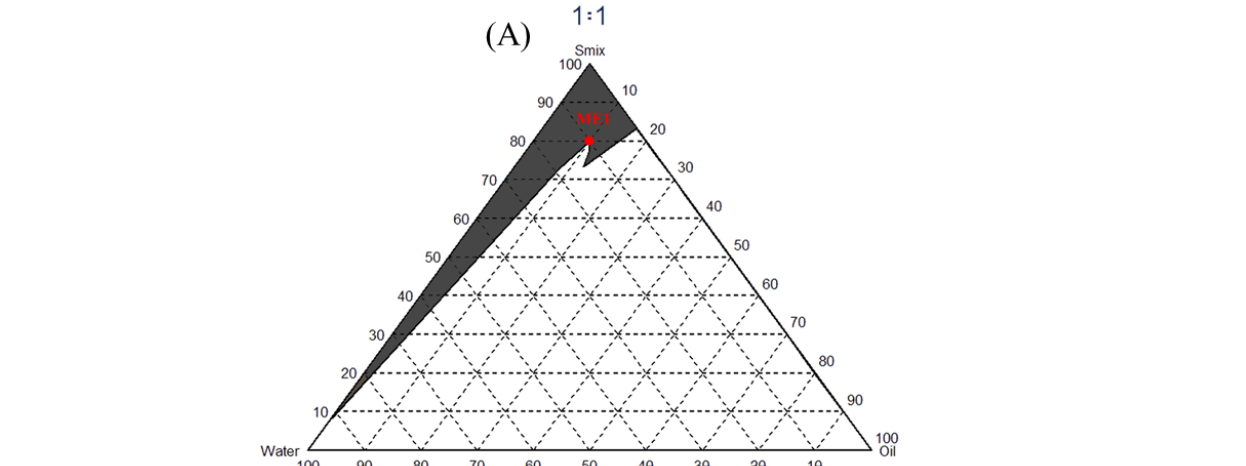
Figure 2. The pseudoternary phase diagram of the microemulsion formation with different tween 80 and ethanol ratios. The black area indicates the microemulsion formation. Red dots indicate the selected formula, which produces the microemulsion with less surfactant. ( A ) A 1:1 ratio of tween 80: ethanol, ( B ) a 1:2 ratio of tween 80: ethanol, and ( C ) a 2:1 ratio of tween 80: ethanol.